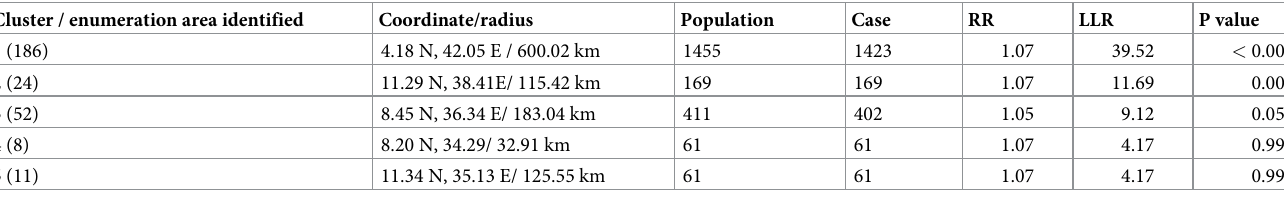
Table 3. SaTScan result analysis, EDHS 2016. Cluster / enumeration area